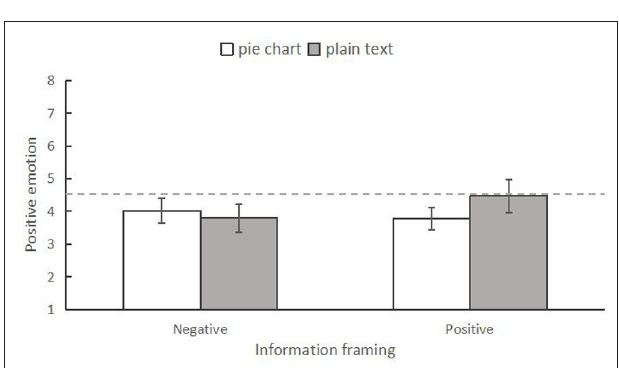
FIGURE 7 | The interaction between information frame and information form on positive emotion in Experiment 2. The error bars indicated 95% CI.